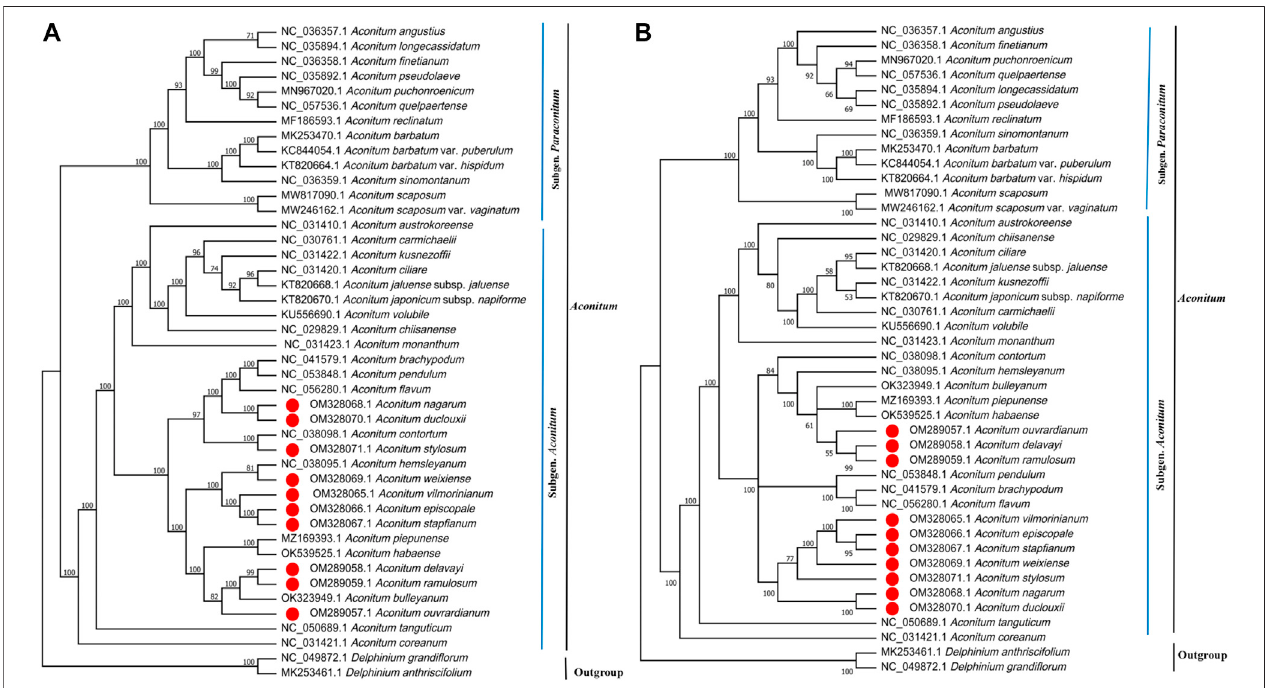
FIGURE 11| Phylogenetic relationship of 42 Aconitum species inferred from Maximum Likelihood (ML) based on two data sets. (A) ML tree constructed based on complete chloroplast genome. (B) ML tree constructed based on protein-coding genes (PCGs).